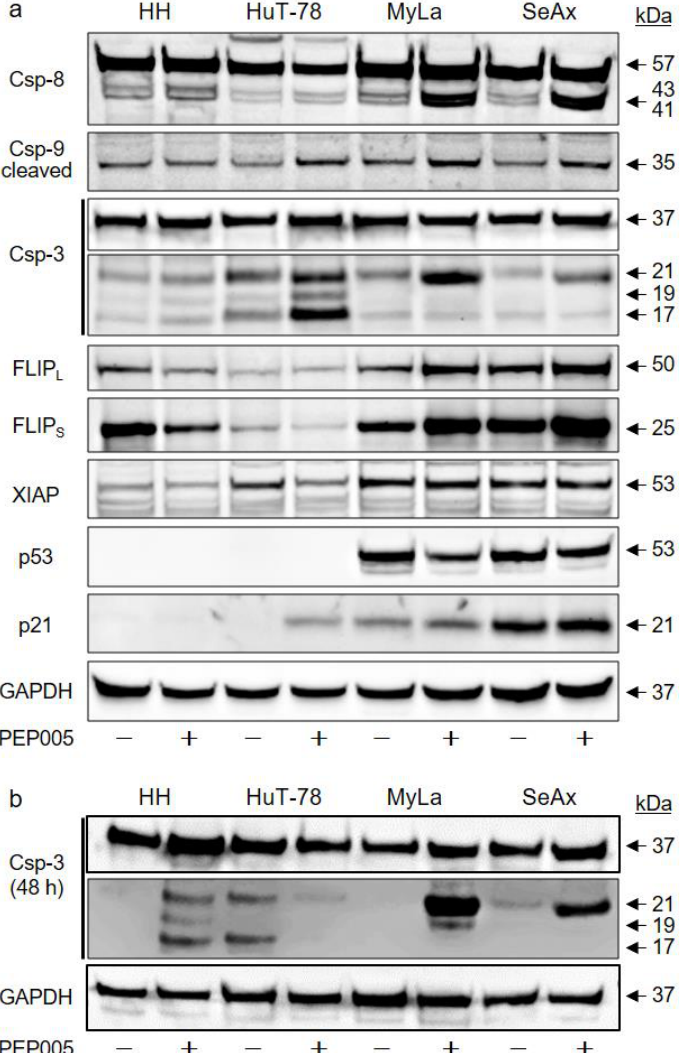
Figure 4. Effects on protein expression. ( a ) Effects of PEP005 (50 nM) on caspases and other apoptosis-related proteins were determined by Western blotting in four CTCL cell lines at 24 h of treatment. ( b ) For caspase-3, 48 h treatment was also investigated. ( a , b ) An amount of 30 µg of each protein extract was loaded per lane. Blots were probed with antibodies for caspase-8 (proform, 57 kDa; cleavage products, 43, 41 kDa), caspase-9 (cleavage product, 35 kDa), caspase-3 (proform, 35 kDa; cleavage products, 21, 19, 17 kDa), c-FLIP long/short isoforms (c-FLIP L/S , 50/25 kDa), XIAP (53 kDa), p53 and p21 (53 and 21 kDa, respectively). The housekeeping protein GAPDH (37 kDa) was used as the loading control. Two independent series of protein extracts and Western blotting experiments revealed highly comparable results.